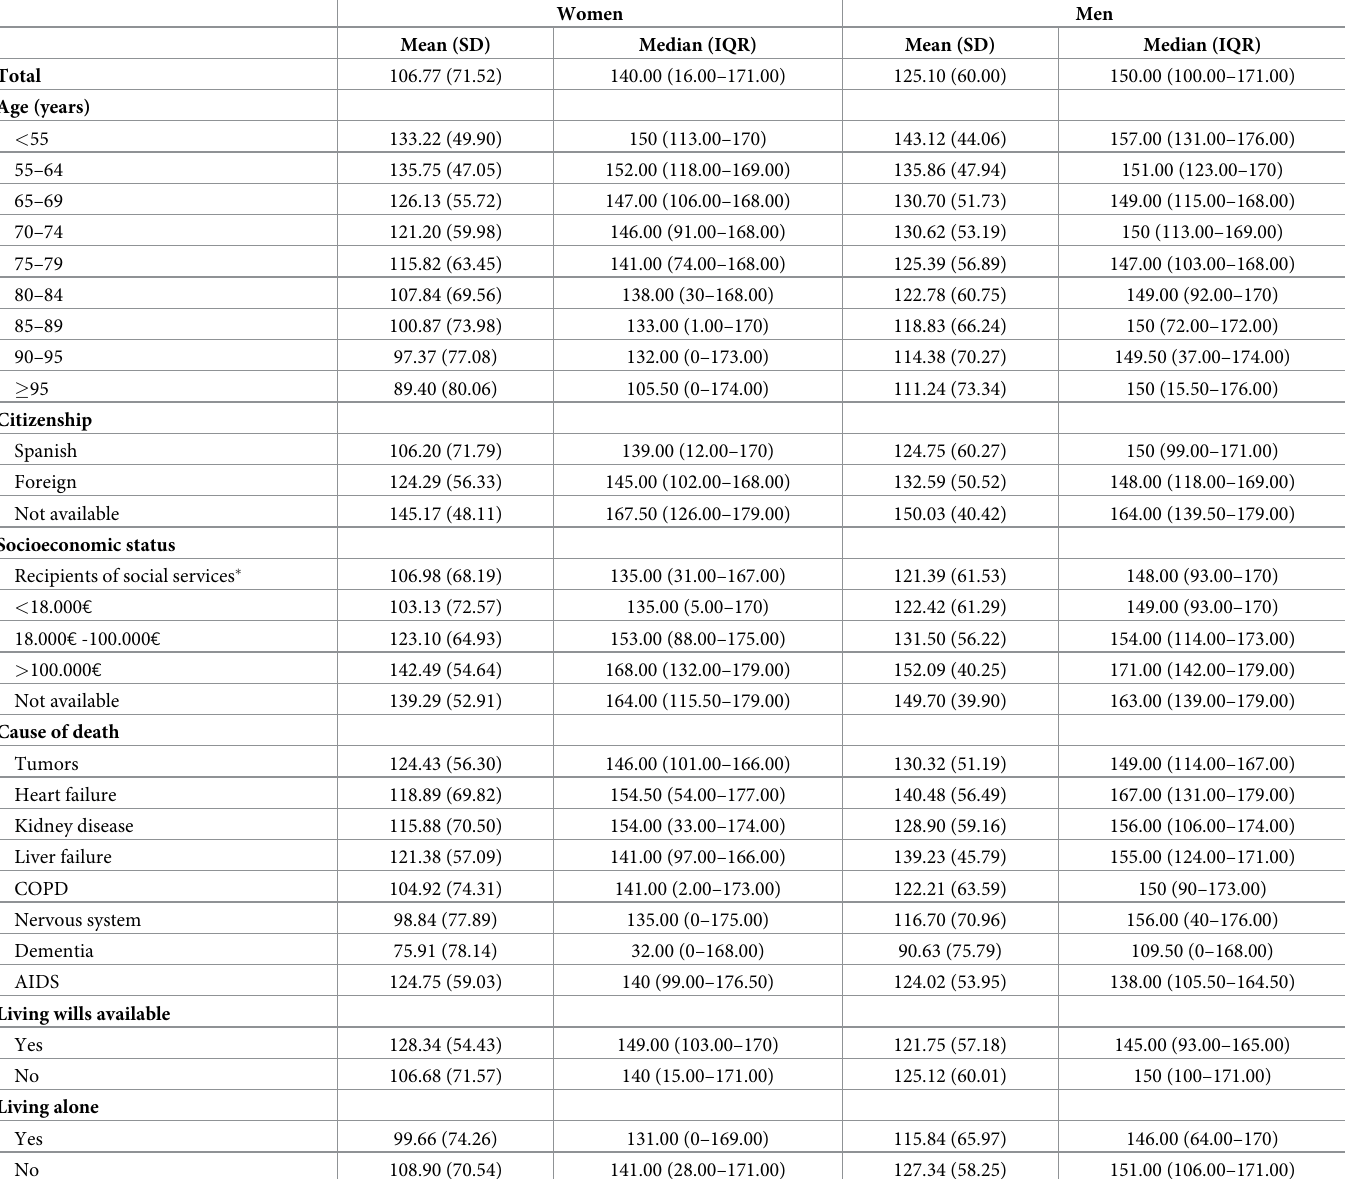
Table 2. Descriptive analysis of the number of days spent at home within the last 180 days of life among women and men, according to clinical and socioeconomic